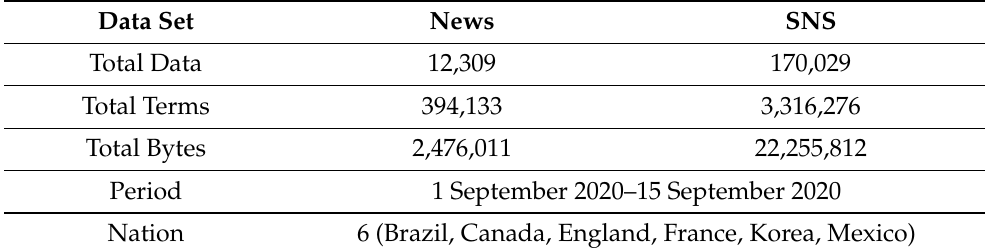
Table 1. Data used for the accuracy experiment of WBiLSTM-TF-IDF.